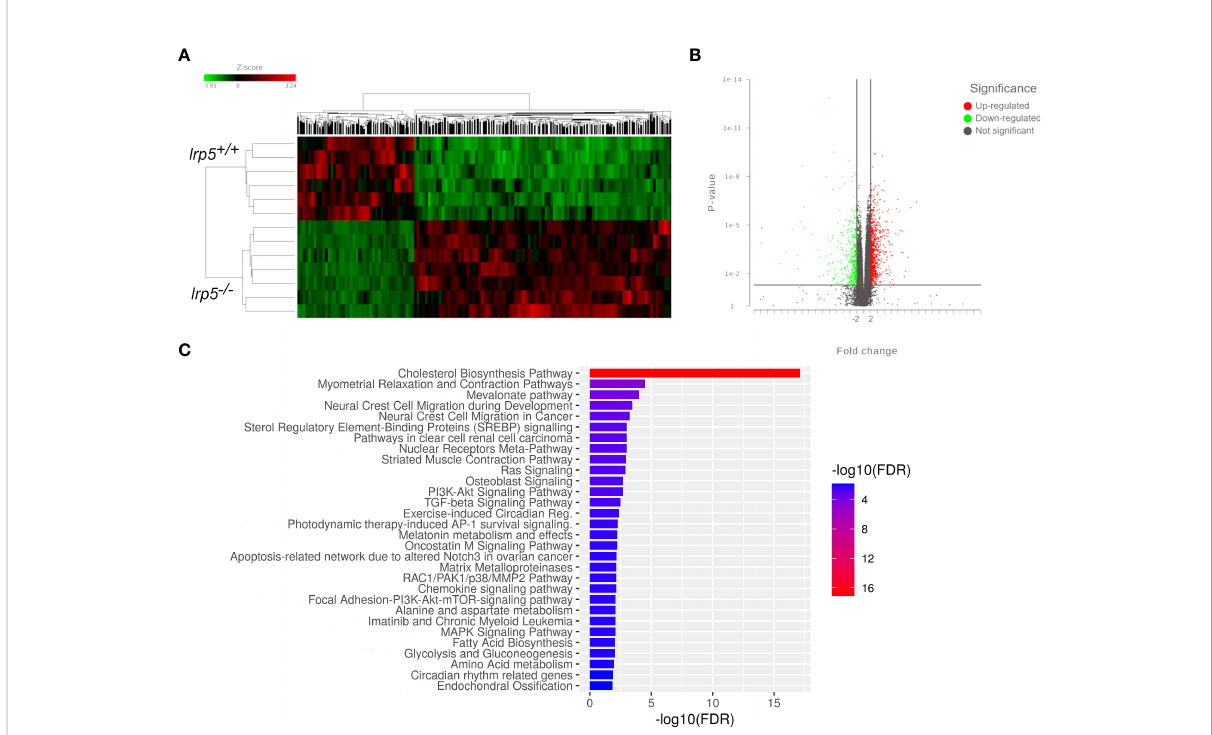
FIGURE 4 RNA-seq results. (A) The overall distribution of differentially expressed genes in the cranial bones between the lrp5 +/+ and lrp5 − / − groups. Red and green represent up-regulated and down-regulated transcripts, respectively, in the clustering analysis. The color intensity is directly proportional to the change. (B) The volcano plot shows DEGs in the lrp5 − / − cranial bones. The red part indicates up-regulated genes, and the green part indicates down-regulated genes. (C) Box plot of pathway analysis for all DEGs.